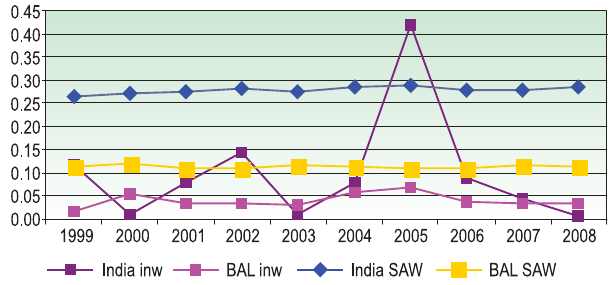
Fig. 10. FDI growth rates vs aggregated index SAW (the third situation)